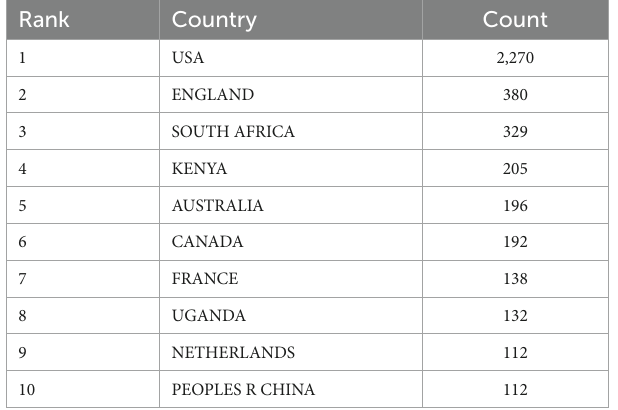
TABLE 2 The top 10